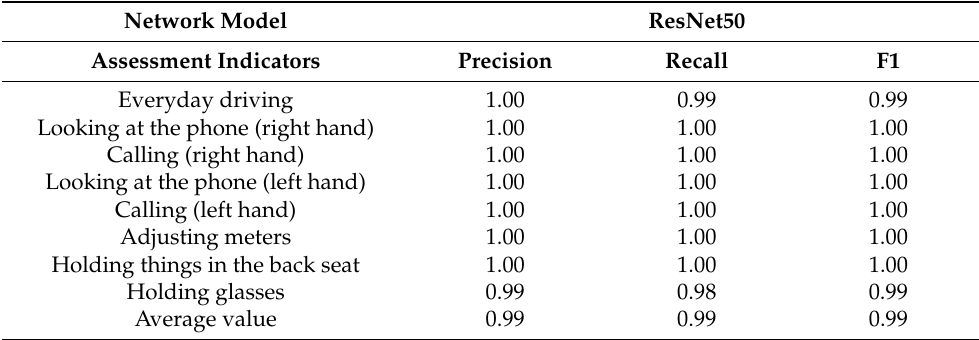
Table 1. ResNet50 model test results.